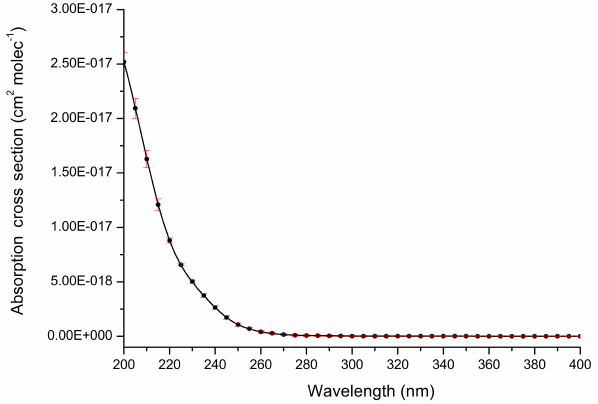
Figure 6. Absorption cross section of the ammonium iodate solu- tion (error bars in red).